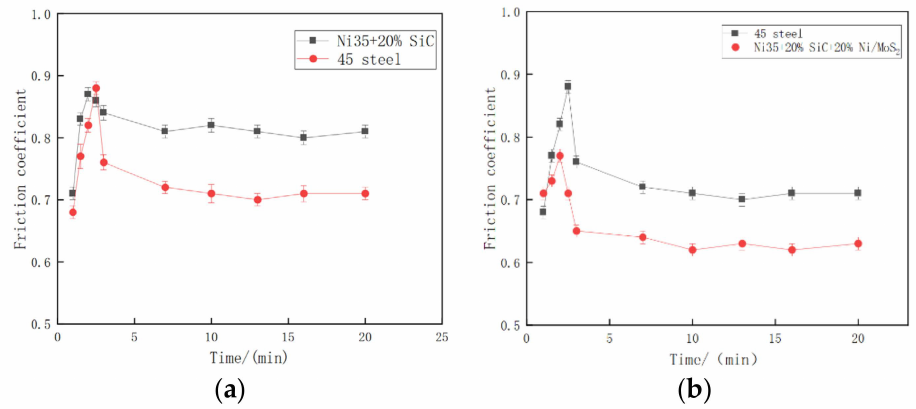
Figure 10. The variations in friction coefficient of grade 45 steel and coating with the wear